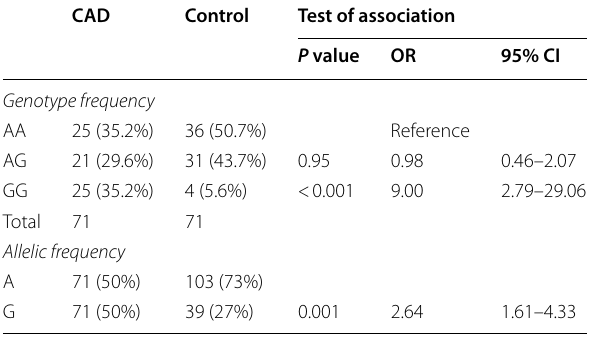
Table 3 Genotypic and allelic distribution of PON1 rs662 gene polymorphism in CAD and control